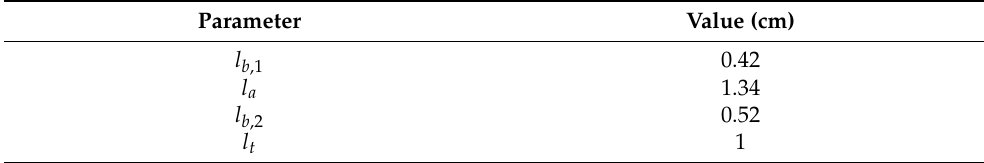
Table 2. Lengths of the air and biological tissues for the multi-layer model.